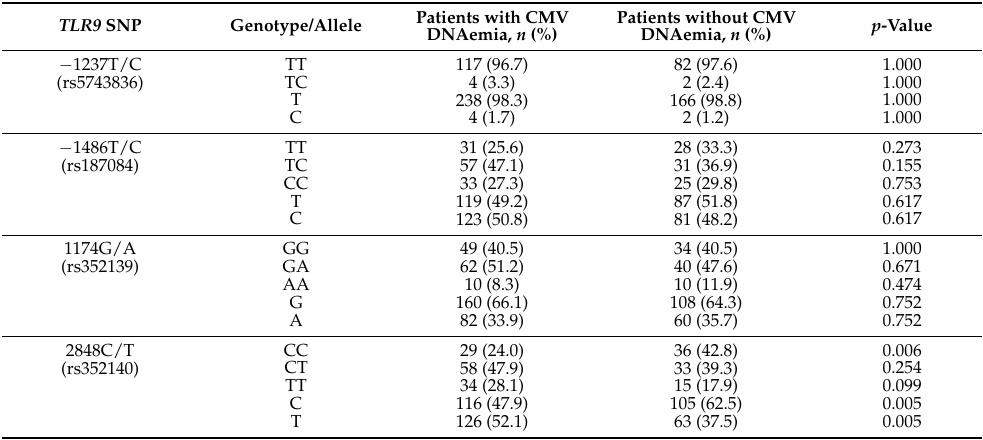
Table 2. Genotype and allele frequencies of the TLR9 SNPs in HIV/CMV co-infected patients. TLR9 SNP Genotype/Allele Patients with CMV DNAemia, n (%) Patients without CMV DNAemia, n